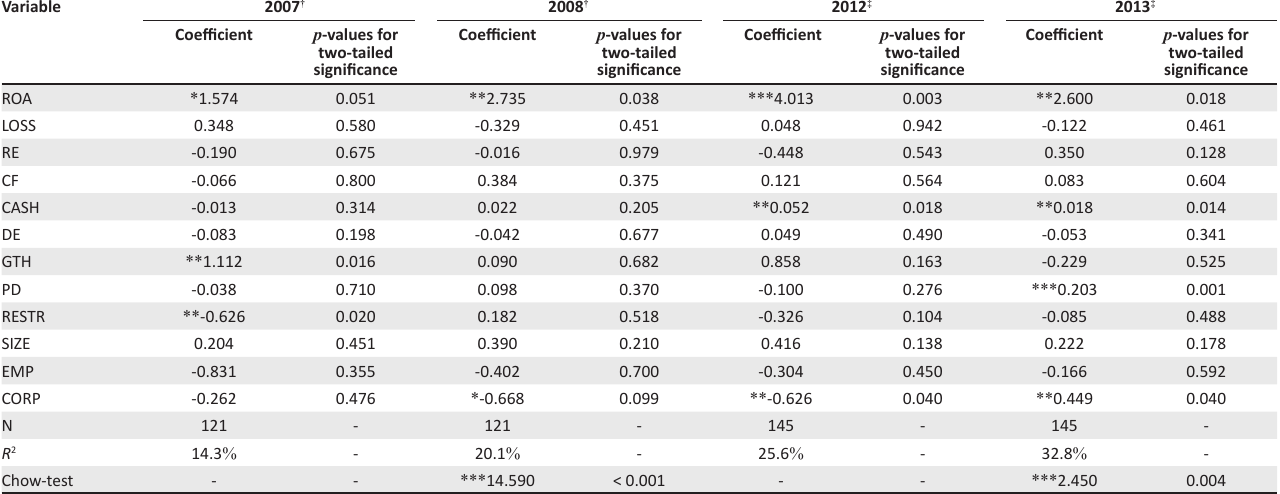
TABLE 4: Main regression results.